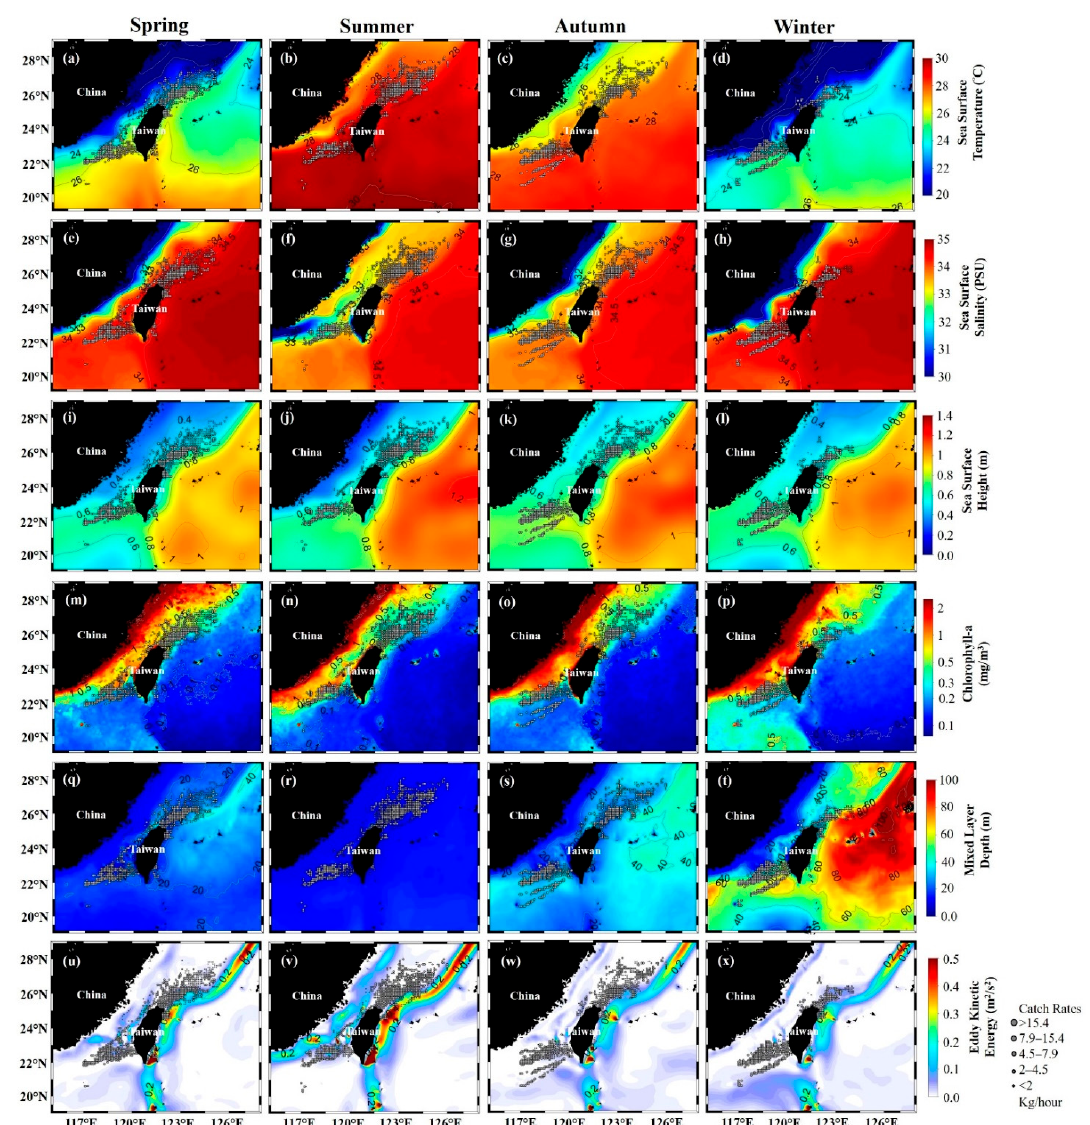
Figure 4. Seasonal average observed catch rates of S. dumerili overlaid with environmental factors: